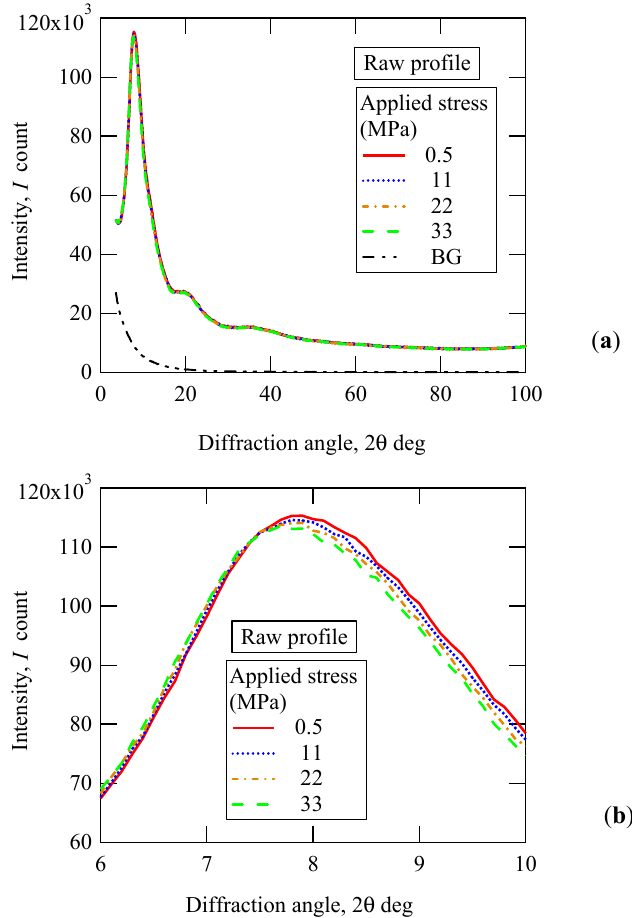
Figure 4. Change in diffraction profile due to applied stress: ( a ) Wide range of profiles; ( b ) Enlargement of figure ( a ).